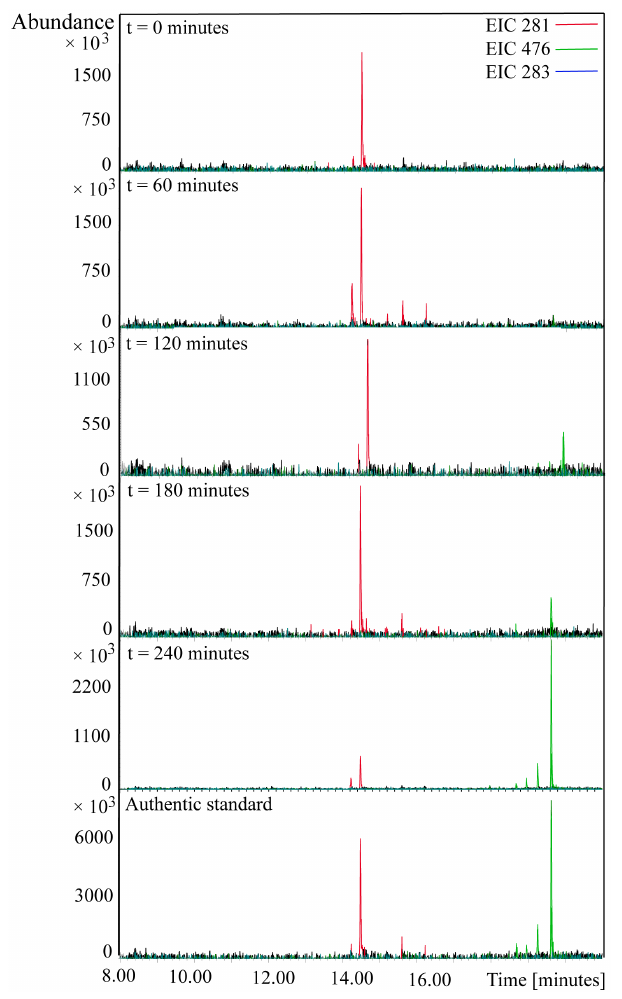
Figure 5. Extracted ion chromatogram (EIC) of m / z 281M ·+ , m / z 476M ·+ , and m / z 283M ·+ during the oxidation of MEK and EIC of the authentic standard